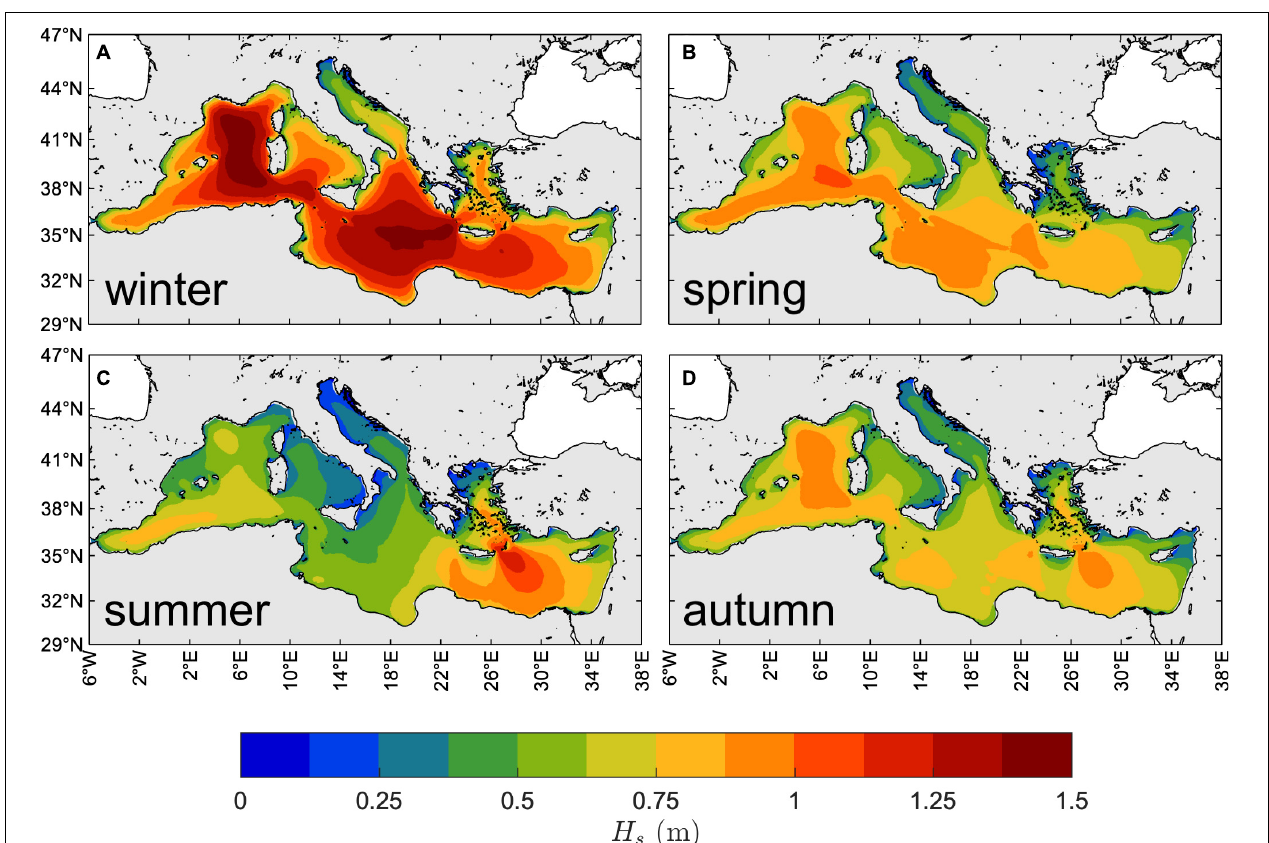
FIGURE 4 | Climate of typical MS wind waves. Yearly-averaged seasonal 50th percentile of H s (1981–2019): winter [NDJFM, panel (A) ], spring [AM, panel (B) ], summer [JJA, panel (C) ], and autumn [SO, panel (D) ].